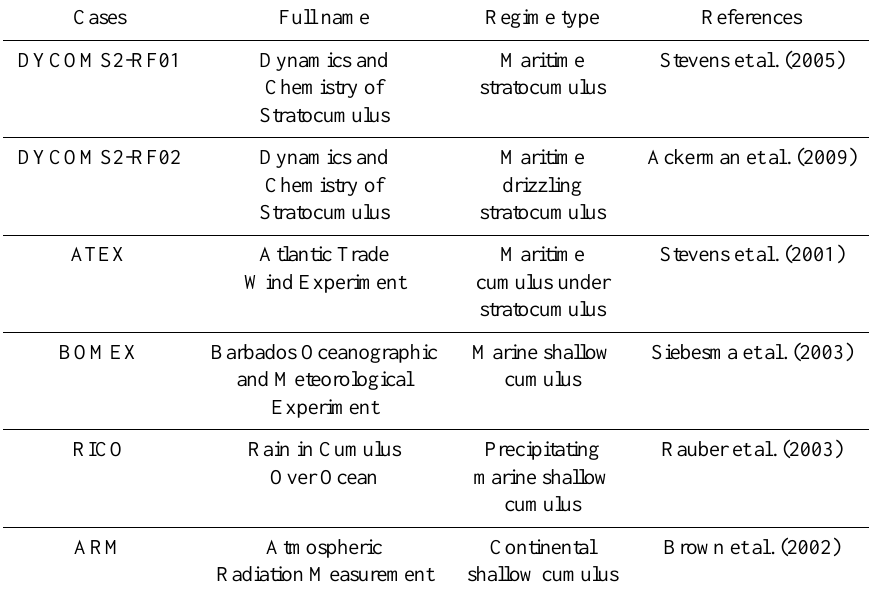
Table 1. Summary of cases used for single-column CAM